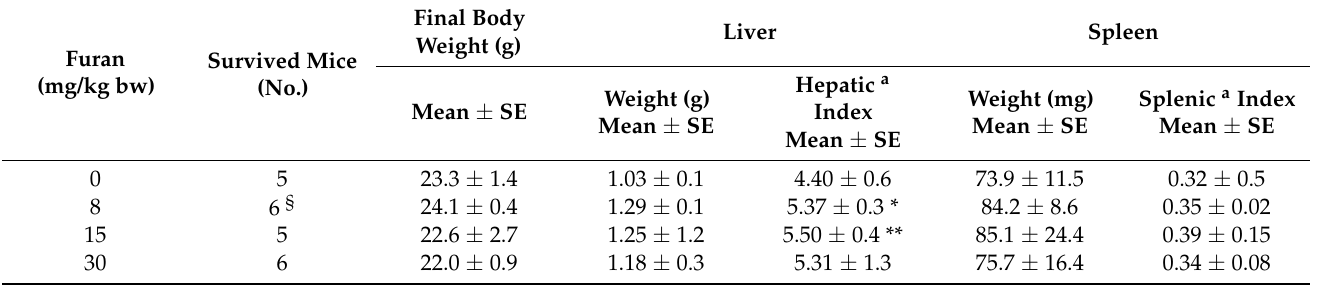
Table 4. Body weight gains and organ weights of C57Bl6 mice after 4 weeks of furan treatment.